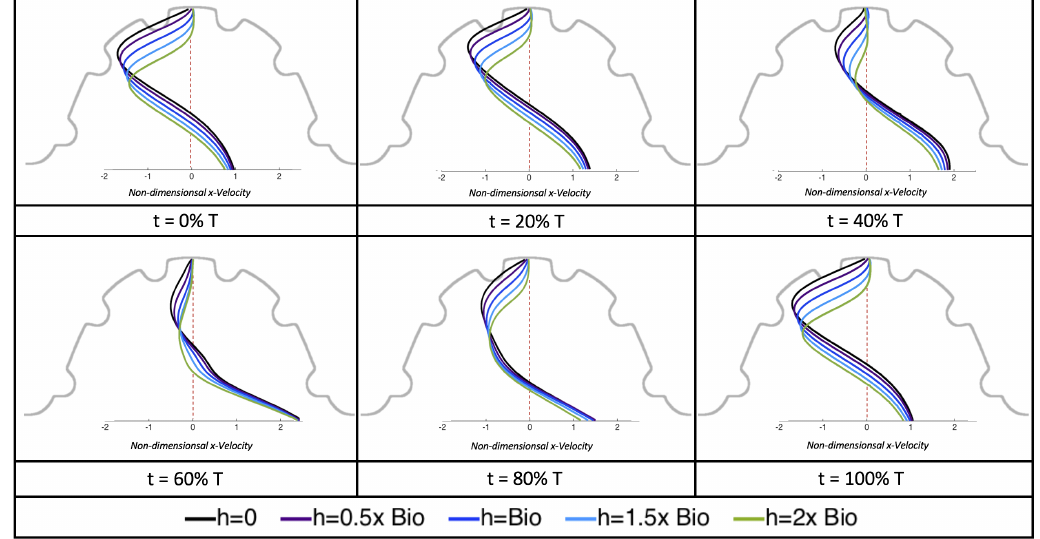
Figure 26. Snapshots during a pulsation cycle in the Re = 100 case of the horizontal velocity measured from the intracardial center to the intertrabecular region directly above for multiple trabeculae